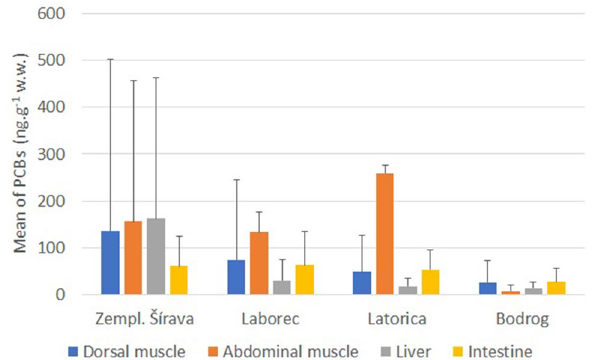
Figure 1. Mean concentrations of PCBs (mean ± SD) in fish matrices (ng g −1 w.w.) from four sampling sites.